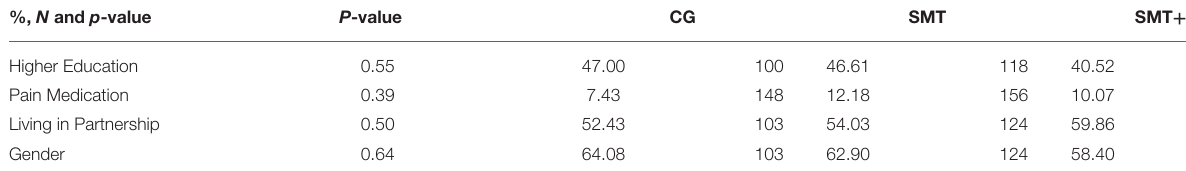
Mean, SD, and quantiles Fear Avoidance Activity FABQ a HADS anxiety